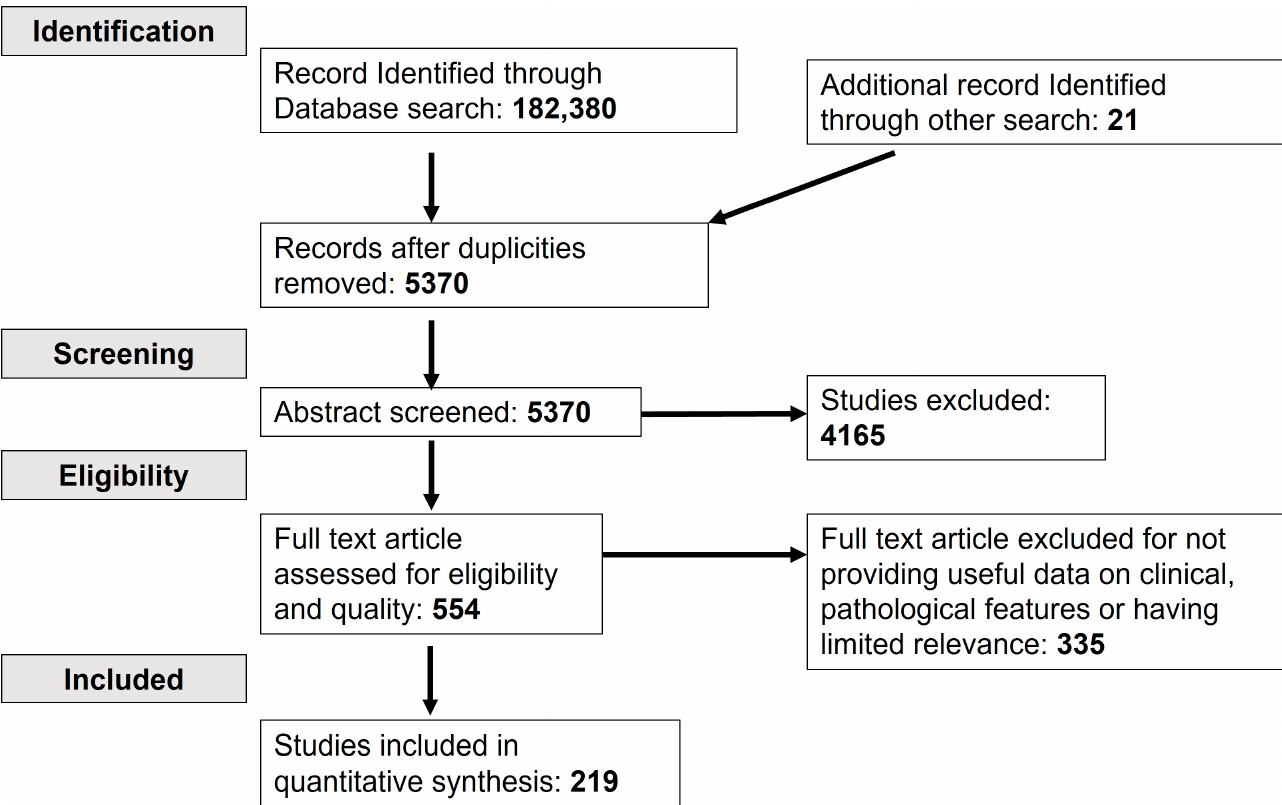
Figure 1. Prisma flow diagram: Preferred Reporting Items for Systematic Reviews (PRISMA) diagram for the selected 219 studies on a diabetes-associated infectious disease and its management.